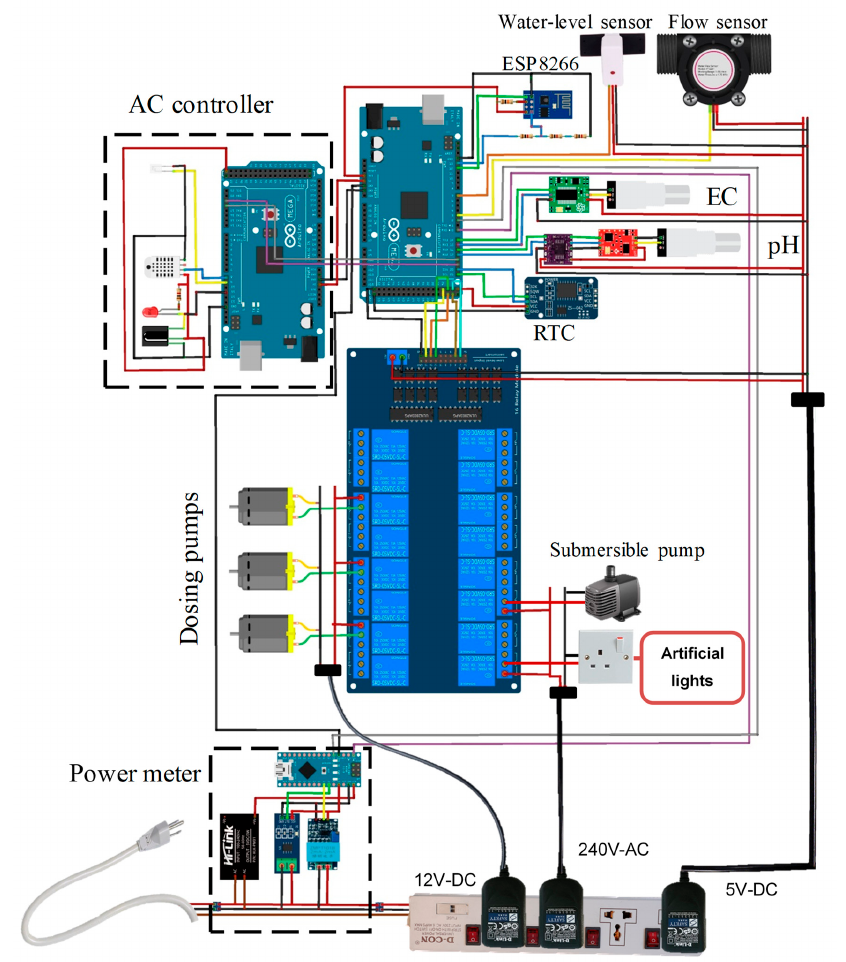
Figure 7. Overall circuit diagram of the system.